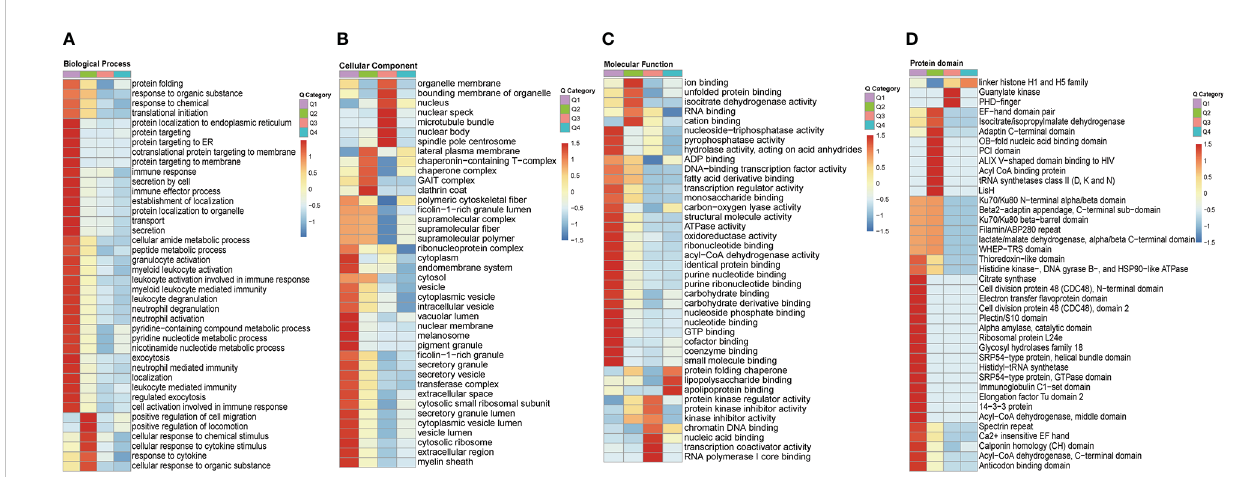
FIGURE 6 Clustering analysis of identi fi ed up-regulted crotonylated proteins and functional characterization of crotonylated proteins. Fold changes of modi fi ed crotonylation sites in MRSA-infected THP1 cells vs. control cells were classi fi ed into four classes; Q4 (>2.0, up-regulated 2.0 fold),Q3(1.5-2.0, up- regulated 1.5-2.0 fold), Q2(0.5-0.667, down-regulated 1.5-2.0 fold) and Q1(<0.5, down-regulated 2.0 fold). Heat maps showing the results of a cluster analysis of (A) Biological Process category analysis, (B) Cellular Component category analysis, (C) Molecular Function category analysis from the GO term, and (D) protein domain